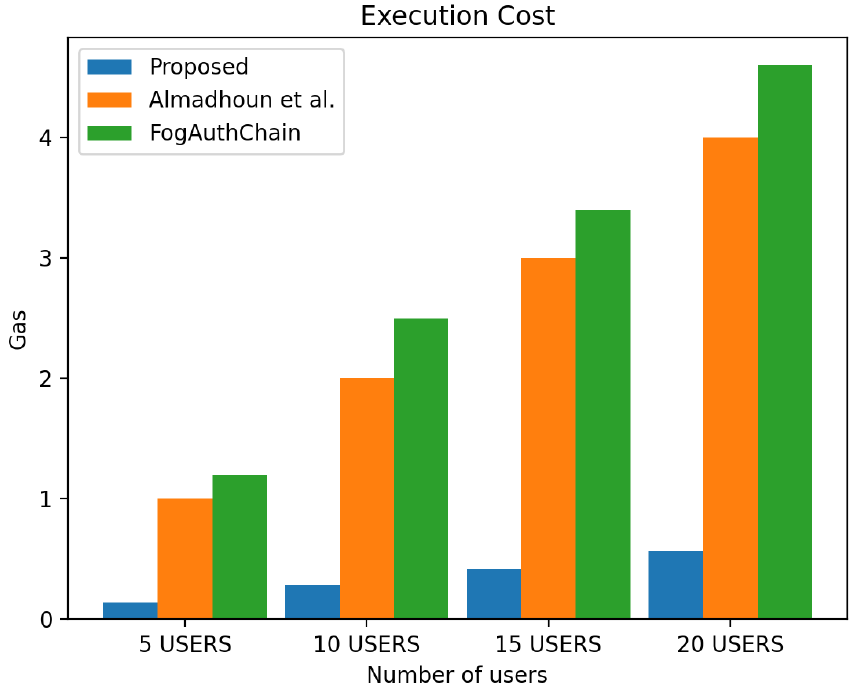
Figure 11. Comparison of experimental results of the proposed system and existing systems (Almad- houn et al. [36] and FogAuthChain [1]) on authentication execution